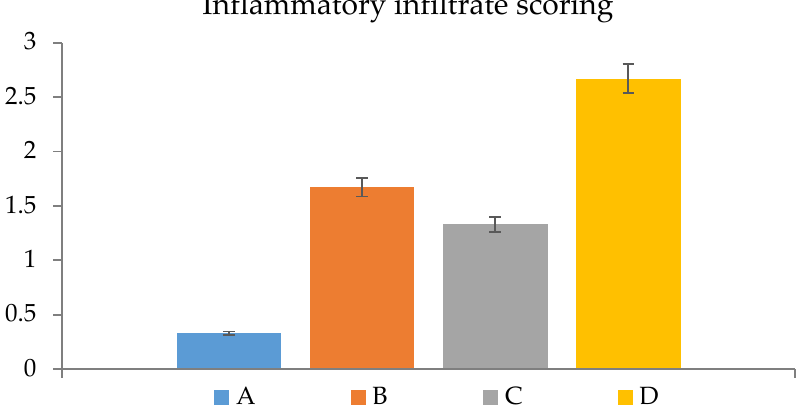
Figure 8. Semi-quantitative assessment of pathological changes after topical application of the different treatments ( n = 5). TTO-loaded nanolipogel (A), the unmedicated nanolipogel (B), TTO-loaded conventional gel (C), and normal saline (D).